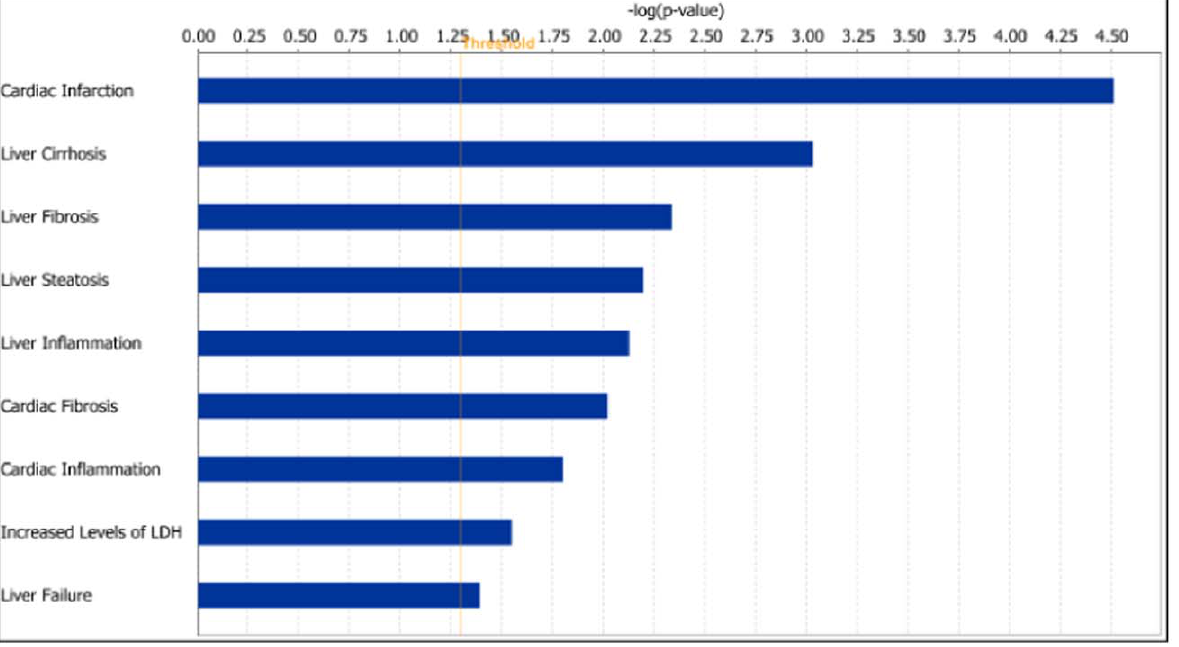
Figure 12. Enrichment of toxicity functions in liver 1 heart 4 cluster 2. This gene cluster has 49 common probe-sets between the top one hundred most influential probe-sets in liver 1 heart 4 cluster 2 (6 mg/kg dose rate). Toxicity functions enrichment for these 49 probe-sets analysed using the IPA software is shown in this figure. The length of the bars shows theFisher’s exact test p-value for enrichmentfor a particular pathway in the cluster. doi:10.1371/journal.pone.0048238.g012 PLOS ONE |